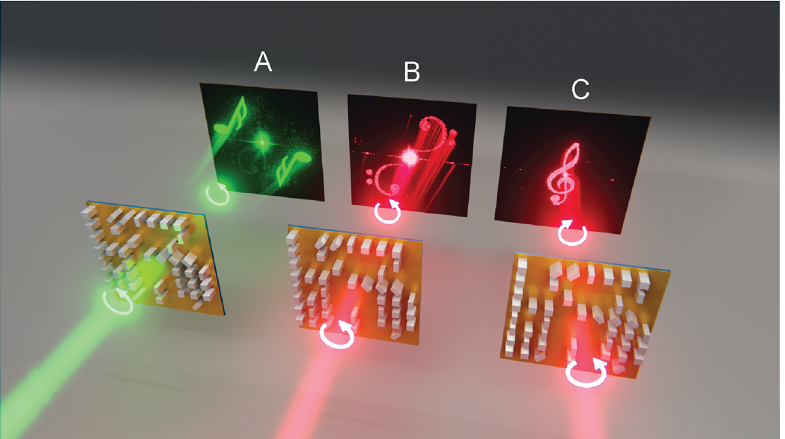
Figure 1: Illustration of the modified photon sieve metahologram working principle.